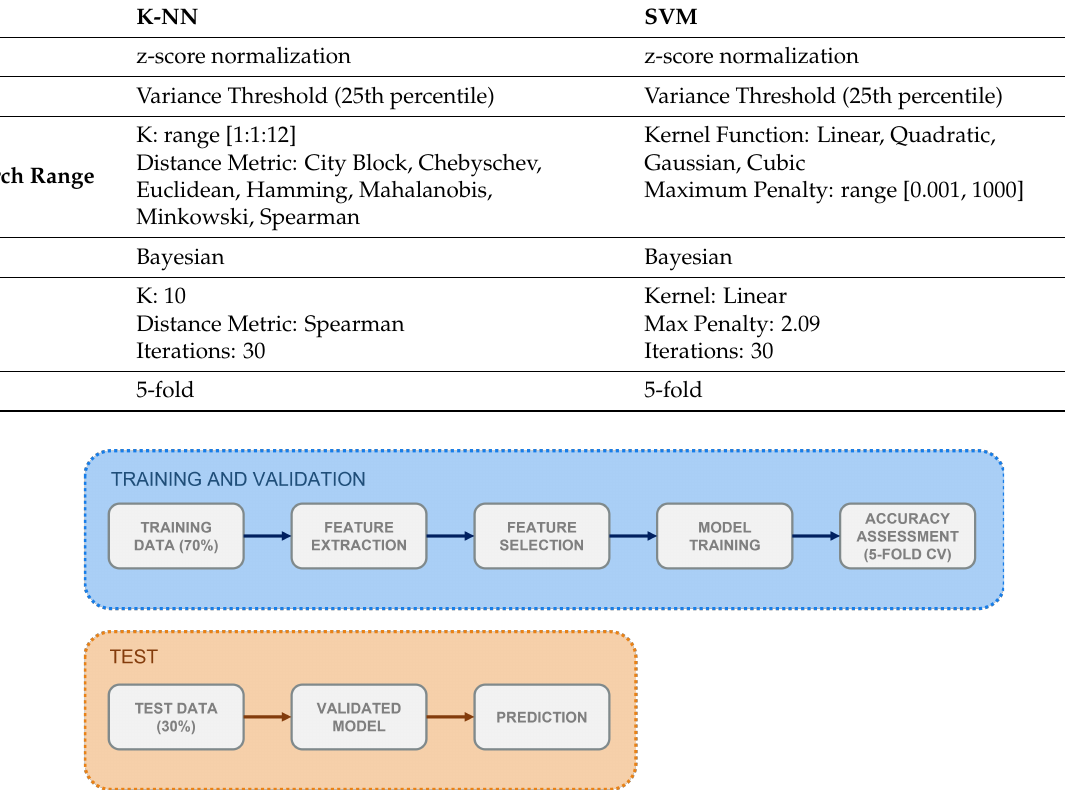
Table 2. Summary of the two employed Machine Learning models: K-Nearest Neighbour (K-NN) and Support Vector Machine (SVM). For each classifier, the chosen feature selection and cross-validation methods, the searched hyper-parameters and the optimised model parameters are presented.